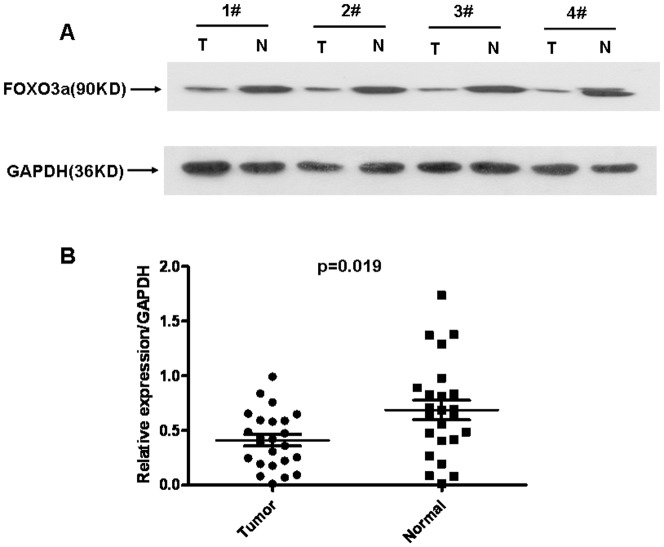
Protein expression of FOXO3a in gastric cancer as evaluated by western blotting.(A) Representative result of FOXO3a protein expression in 4 paired gastric cancerous and the matched adjacent non-tumorous tissues (T, gastric cancer tissues; N, matched non-tumorous gastric mucosa). (B) Relative FOXO3a protein expression levels was remarkably decreased in 18 of 24 (75%) gastric tumor tissues compared with the corresponding adjacent non-tumorous tissues, (FOXO3a/GAPDH, n = 24, p = 0.019).